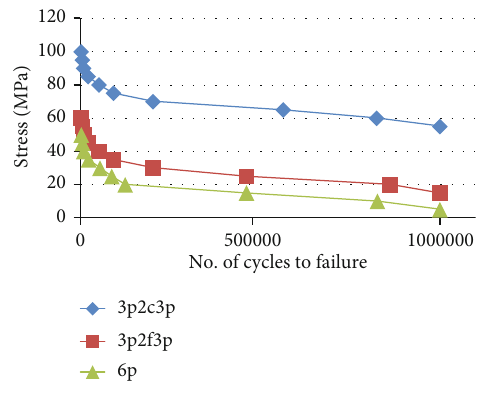
Figure 9: S - N curves for each lamination.